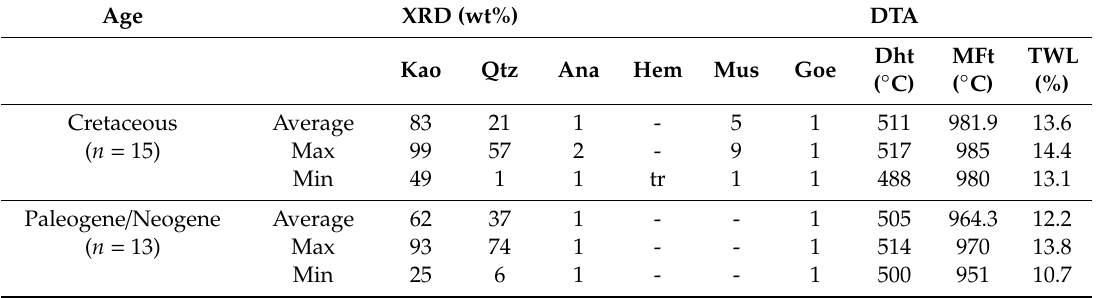
Table 4. Mineral composition, thermal peak temperatures, and total weight losses for the studied Cretaceous–Paleogene / Neogene kaolins.